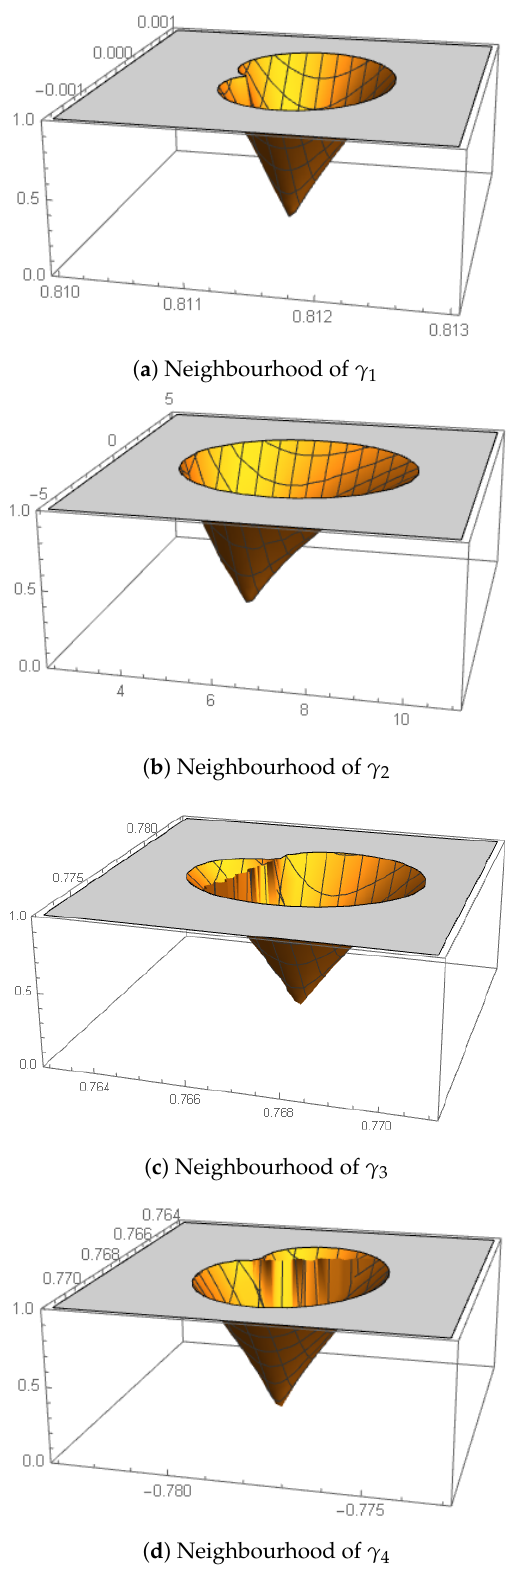
Figure 1. Character of the roots of polynomial k ( t ) : ( a ) γ 1 , ( b ) γ 2 , ( c ) γ 3 , ( d ) γ 4